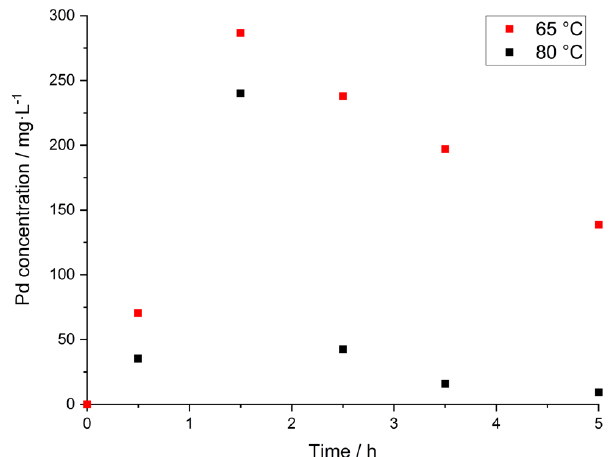
Figure 7. Pd-concentration during leaching at higher temperatures; solid conc.: 50 g/0.1 L; H 2 O 2 :Ag: 3:1; c : 100 g/L above the stoichiometric amount.